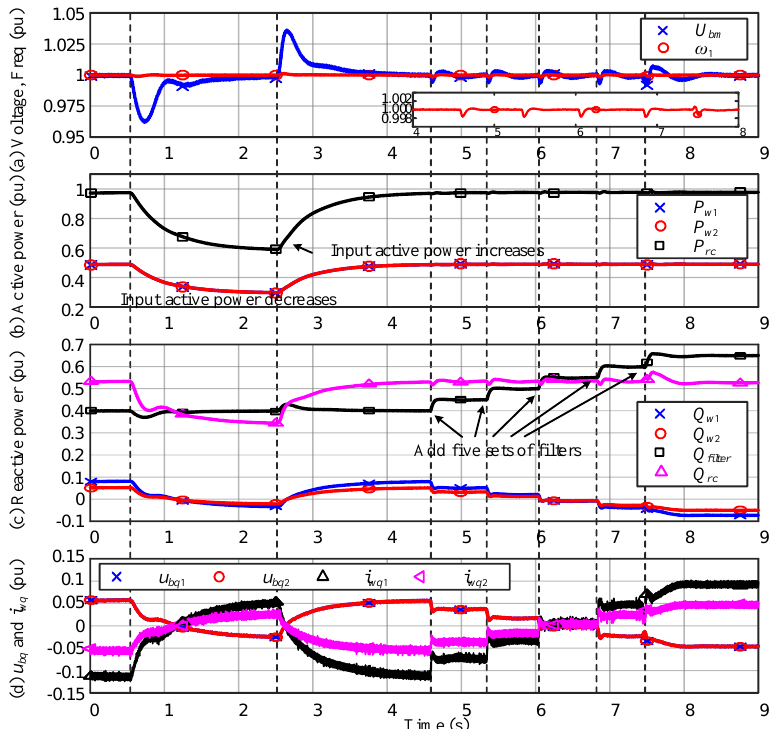
Figure 17. Simulation results under external disturbances, where the WF is represented by two WECSs with the P-type Q - f droop control. ( a ) Sending-end bus voltage and frequency; ( b ) active power; ( c ) reactive power; ( d ) dq -axis sending-end bus voltage. Note that P w 1 , P w 2 denote the active powers outputted by both the WECSs, respectively, similar for Q w 1 , Q w 2 . Q filter denotes the reactive power generated by the filters.